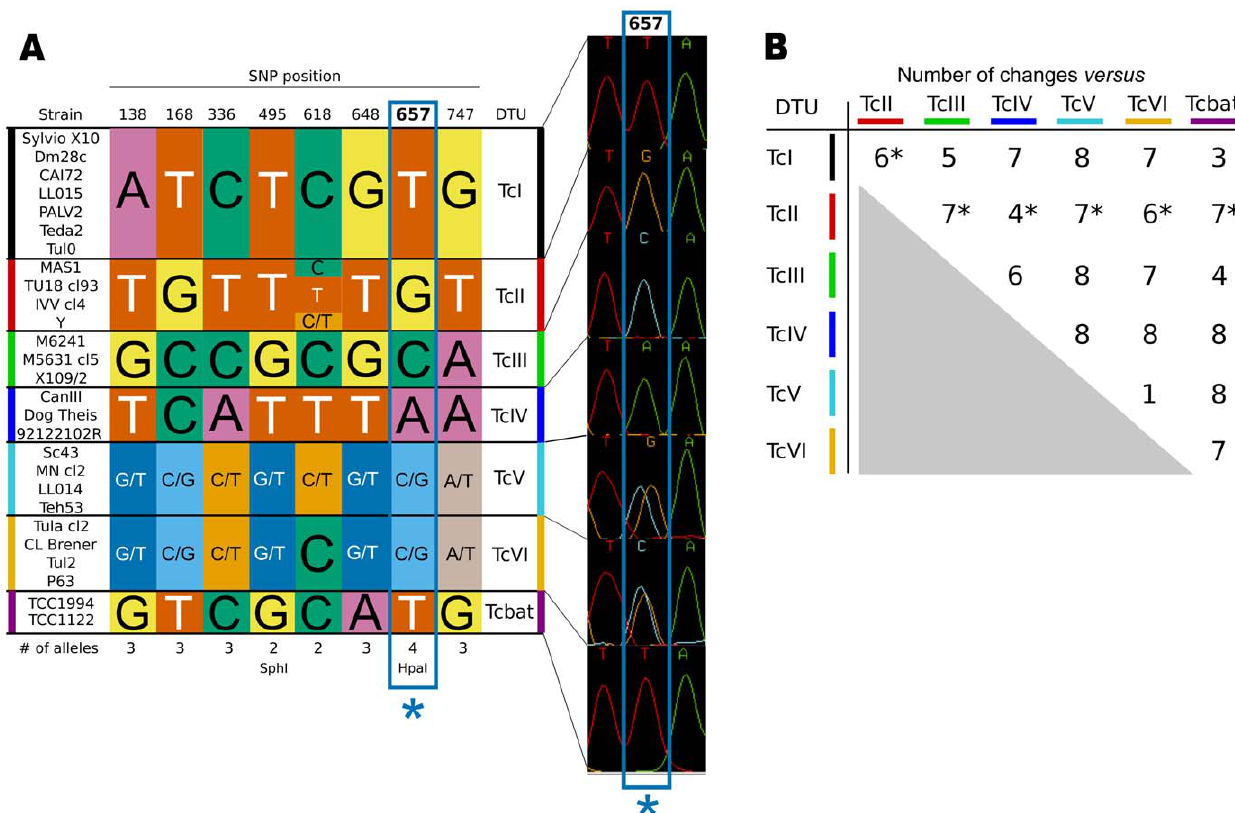
Figure 1. Key polymorphic sites in the T.cruziTcSC5D gene. A: diploid genotypes built from identified highly informative sites (see main text), showing a section of one chromatogram around the tetra-allelic SNP at position 657. B: Summary of observed nucleotide changes between DTUs for these six sites. In the case of the comparisons with the TcII DTU, this is the minimum expected number of changes (marked with * in the figure), because of the diversity observed at position 618 in strains from this DTU.